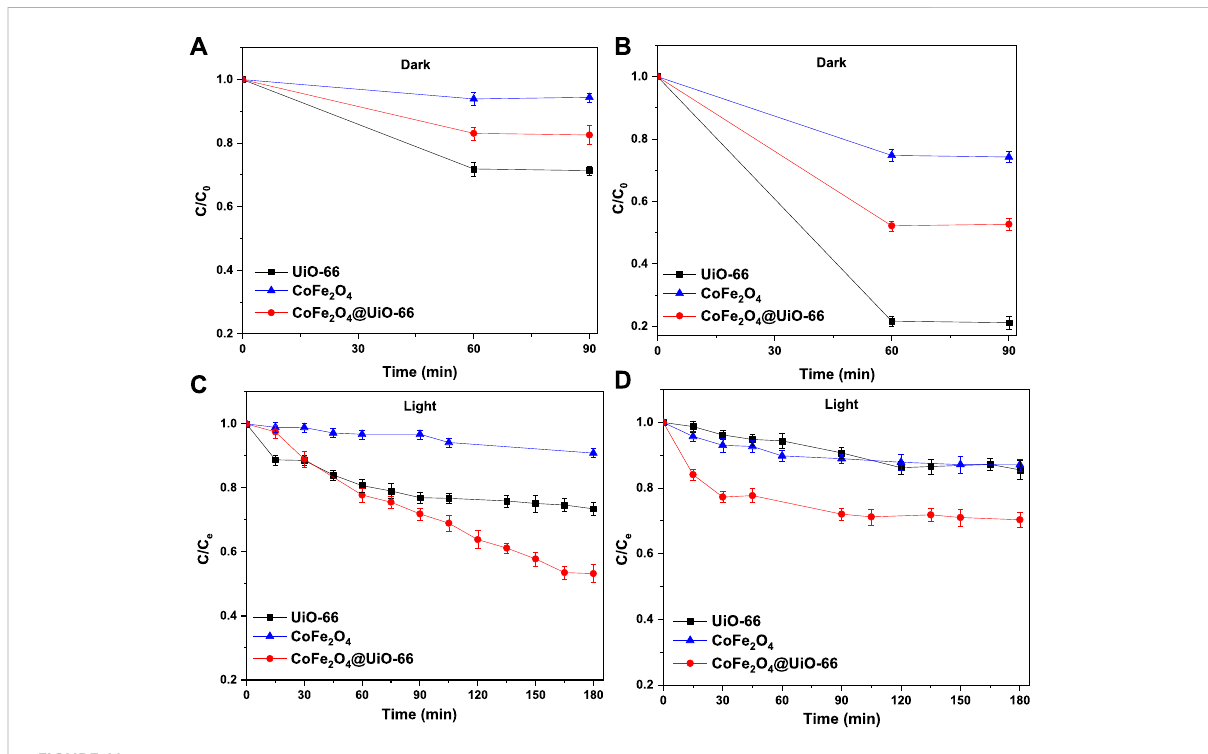
FIGURE 11 Adsorption and photodegradation performance of as-synthesized photocatalysts for removal of MB (A,C) and MO (B,D)